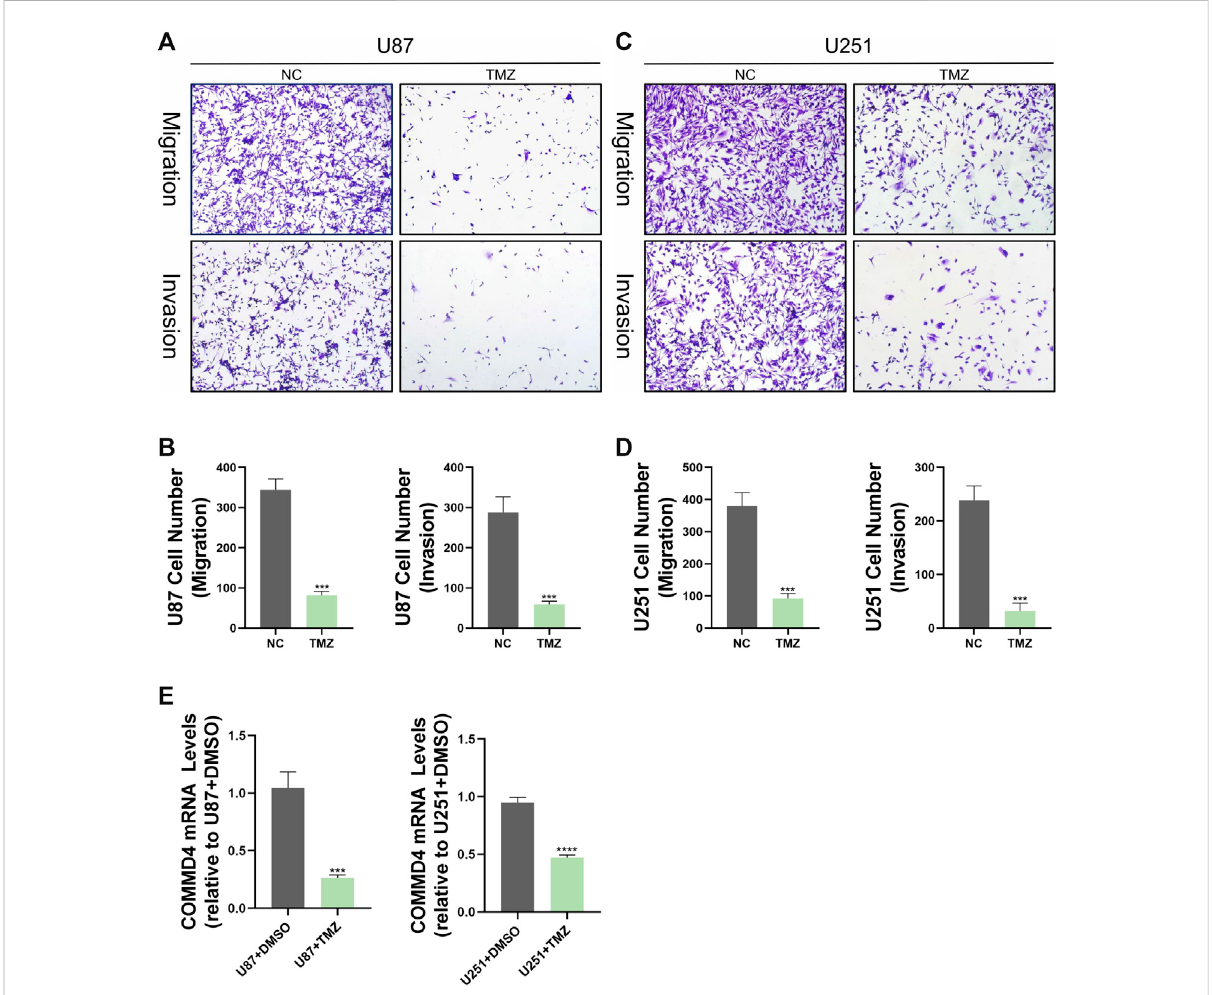
FIGURE 10 TMZ inhibits migration and invasion of glioma cells in vitro and reduces COMMD4 expression. (A – D) Transwell assay images of migration and invasion in the NC and TMZ groups, and quantitative counts of cell numbers (E) Relative quantitative analysis of COMMD4 expression in the NC and TMZ